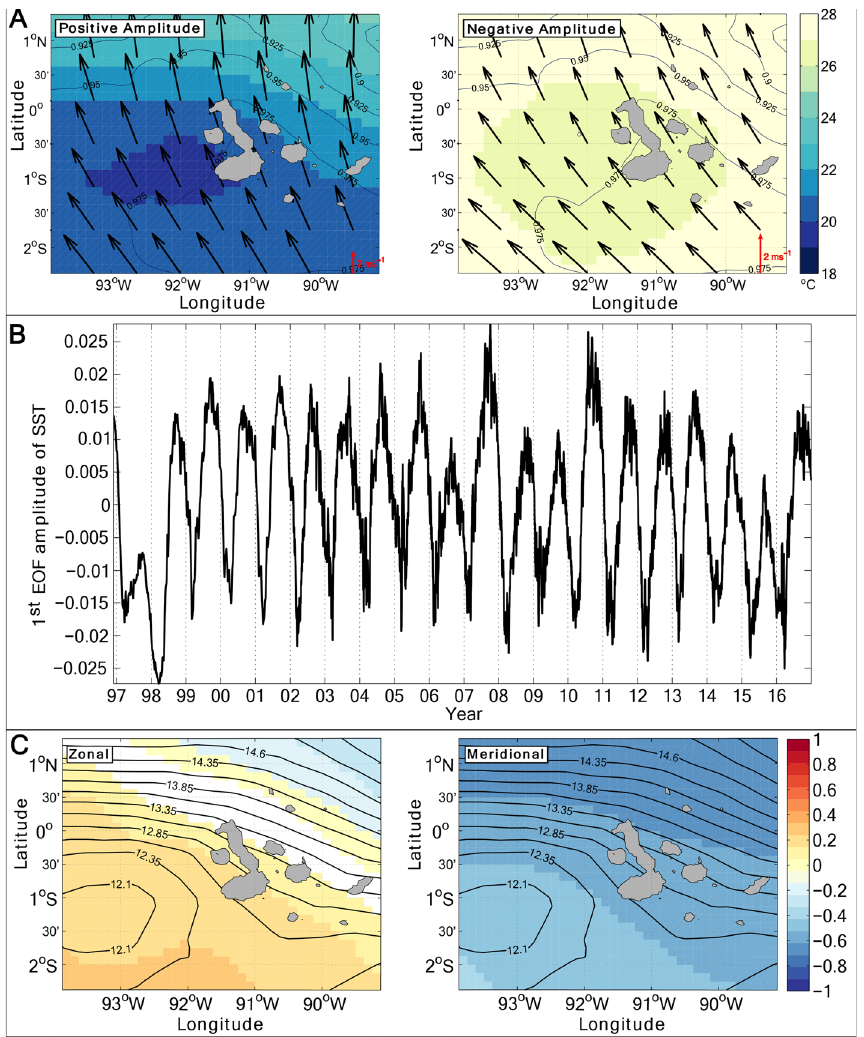
Figure 2. Patterns and correlations of sea surface temperature and wind around the Galápagos. ( A ) Mean sea surface temperature (SST) for days with positive and negative amplitudes of the first empirical orthogonal function (EOF) of ERA-Interim reanalysis SST 13 . Black contours show the spatial correlation between SST and first EOF of SST. Black arrows indicate mean wind velocity vectors for each period. ( B ) Amplitude of the first EOF of SST. ( C ) Maps of the correlation between the first EOF of SST and the zonal and meridional wind stresses. Areas of no colour indicate less than 99% confidence in the correlation (p > 0.01). Black contours show SST for the maximum amplitude of the first EOF (5 October